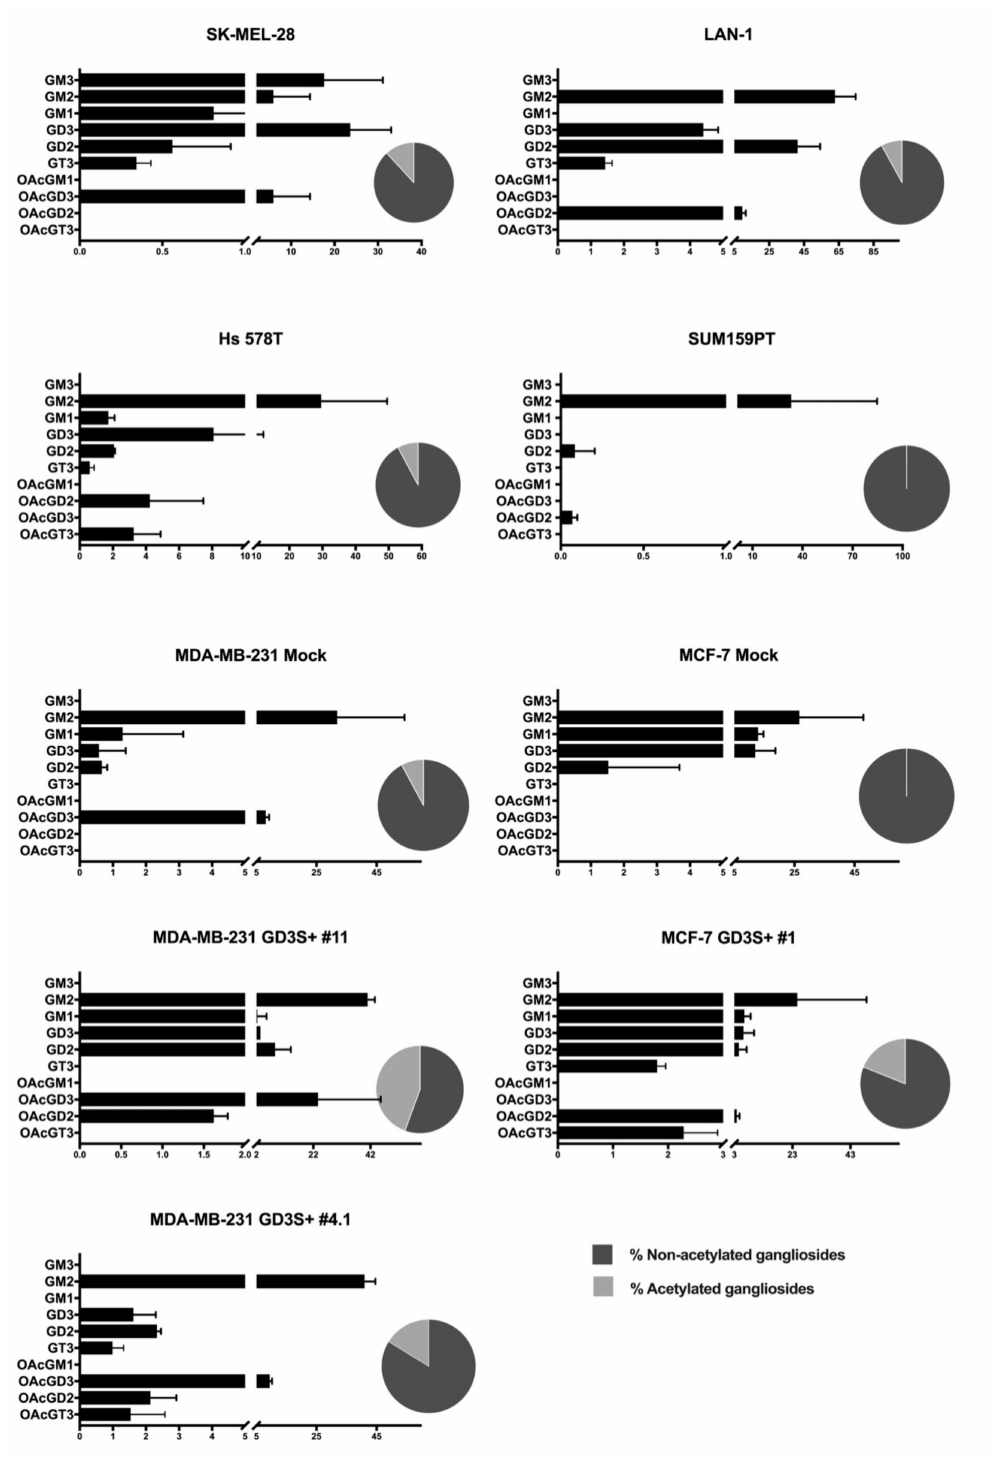
Figure 5. Relative quantification of the global content of main ganglioside species by MALDI-QIT-TOF. Relative quantification of ganglioside content of the apex intensities (mV) of the peak assigned on MALDI-QIT-TOF spectra ( n = 3). Total ganglioside content was normalized to 100 for each cell line. The relative amount of each species is calculated as the percentage of the total ganglioside content. Pie charts represent the percentage of total acetylated gangliosides (light grey) vs. non-acetylated (dark